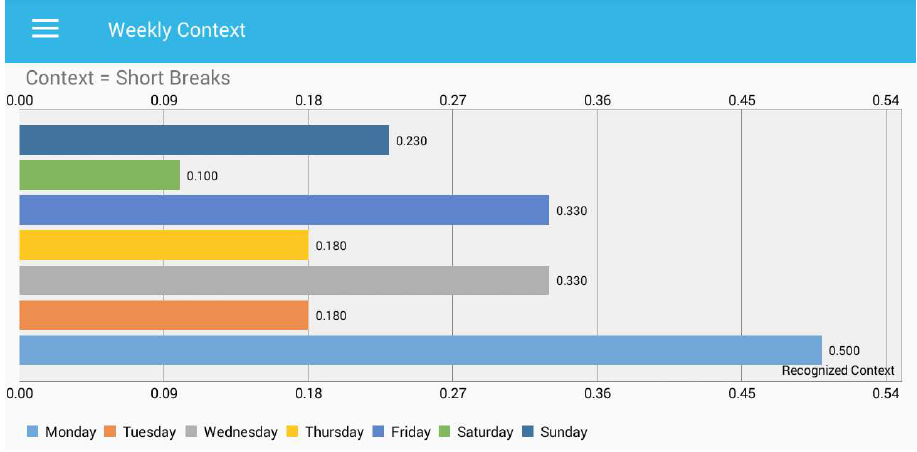
Figure 11. Total time spent during a week for “short